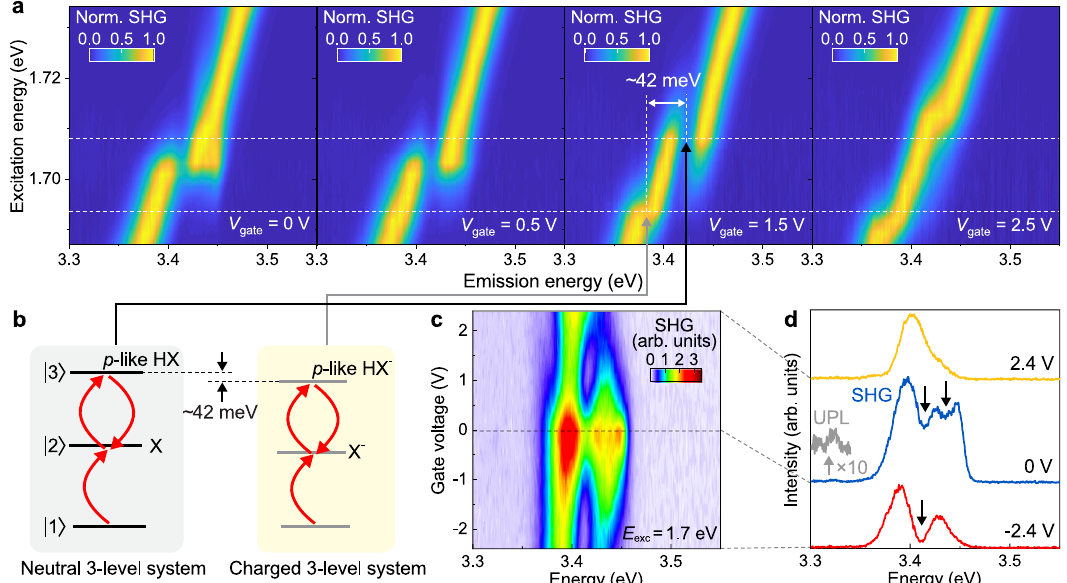
Fig. 4 | Electrical control of excitonic quantum interference involving the p - likehigh-lyingtrioninmonolayerWSe 2 .a Excitation-energydependenceofSHG spectra at gate voltages of 0, 0.5, 1.5, and 2.5V, measured under excitation by a laserof80fspulselength. b Illustrationofanexcitonicthree-levelsystembasedon neutralandchargedspecies.Theneutralthree-levelsystemisformedbytheband- edgeAexcitonandthe p -likeHX.Anegativelychargedthree-levelsystemisformed